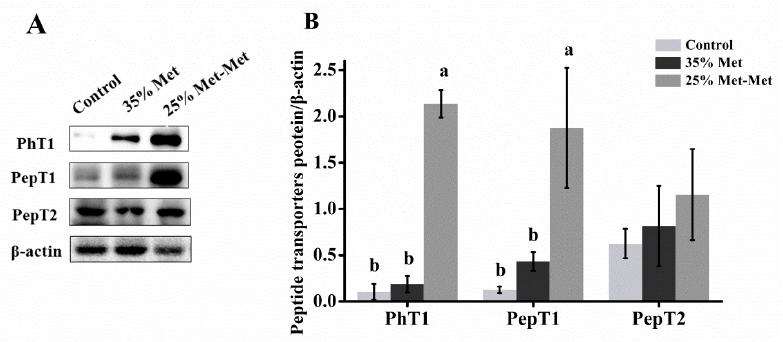
Figure 7. Representative immunoblots ( A ) and blot density analysis ( B ) of peptide/histidine transporter 1 (PhT1), peptide transporter 1 (PepT1), and peptide transporter 2 (PepT2) in the placenta of mice at day 17. In the control group, pregnant mice were fed a diet containing free Met. In the 35% Met group, pregnant mice were fed a Met-deficient diet with intraperitoneally injection of 35% of the Met contained in the control diet. The 25% Met-Met group was treated as described for the 35% Met group, except that 25% of the injected Met was replaced with methionyl-methionine (Met-Met). The data are expressed as the mean ± SEM; three placentas were selected randomly from each group, n = 3. The different letters indicate significant differences, p < 0.05.